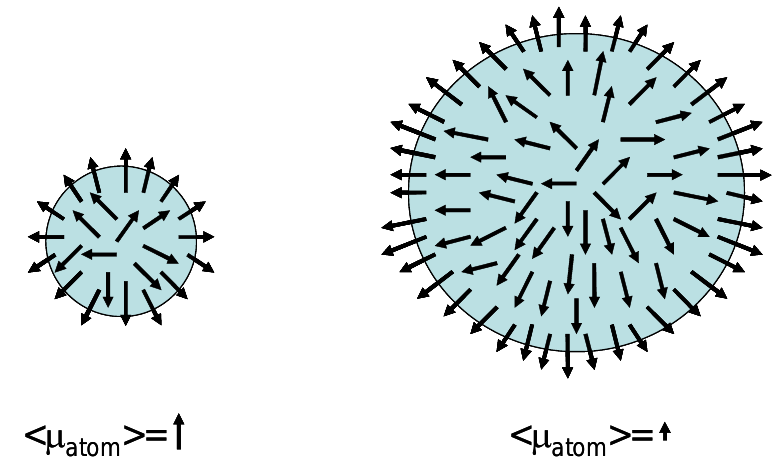
FIGURE 3. Picture of the magnetic moment distribution and average magnetic moment per atom for NP of different size.